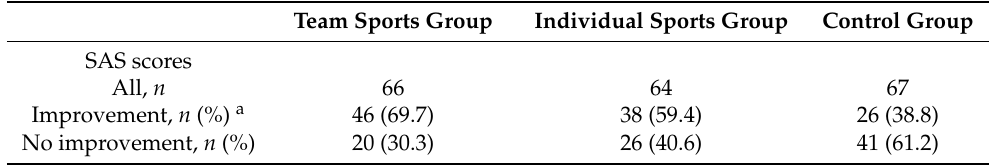
Table 2. The relief of anxiety and the improvement of sleep quality in college students after 6 weeks of